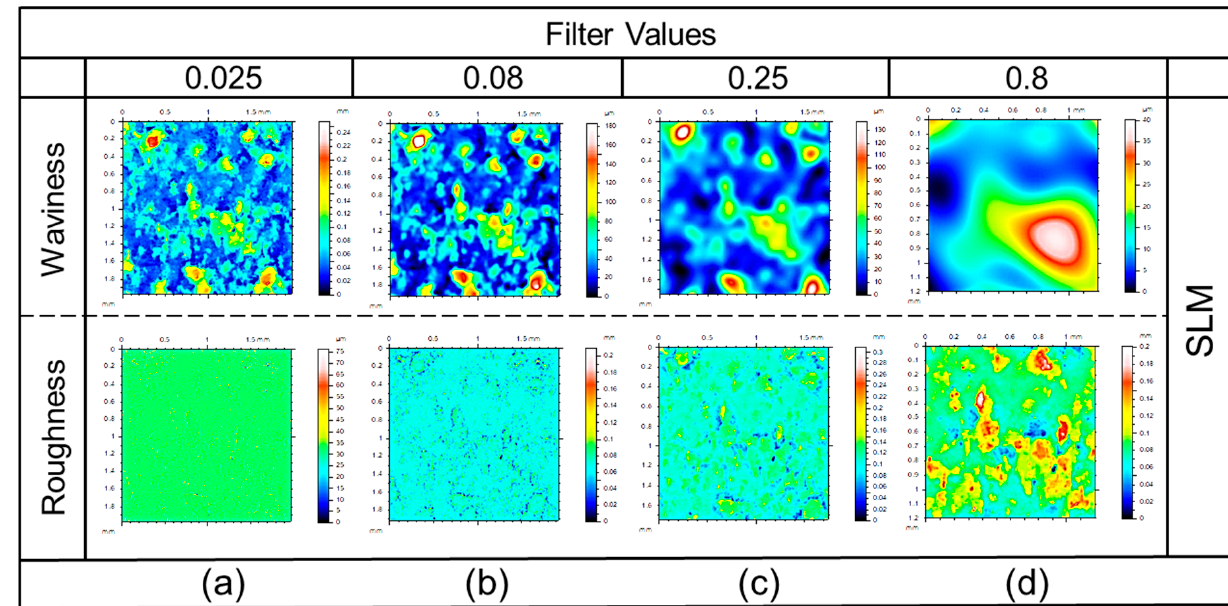
Figure 8. Surface topography of as-built SLM surface after filtering.